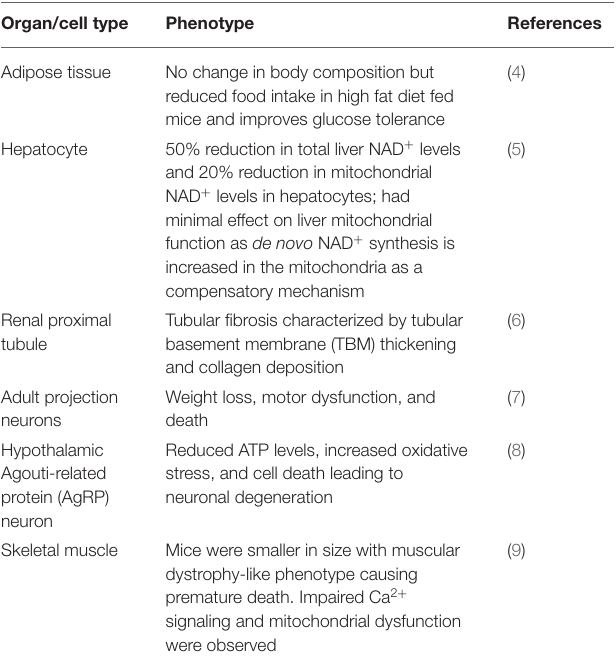
TABLE 1 | Organ specific knockout models of NAD + salvage enzyme Nampt and their